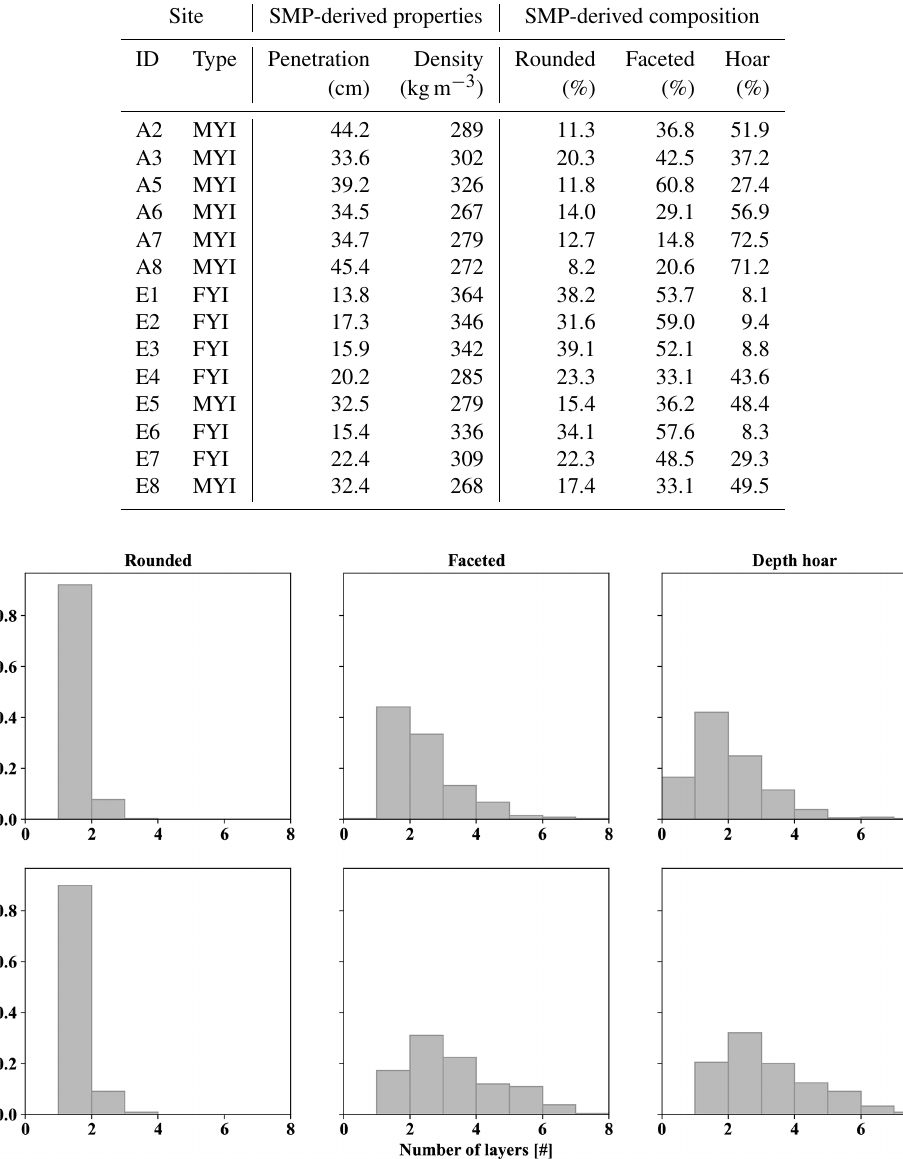
Figure 9. Distribution of the number of snowpack layers as derived from the SMP transect profiles. Transitions between layer types from the automated SMP profile classifications are used as a proxy for traditional snow pit layer